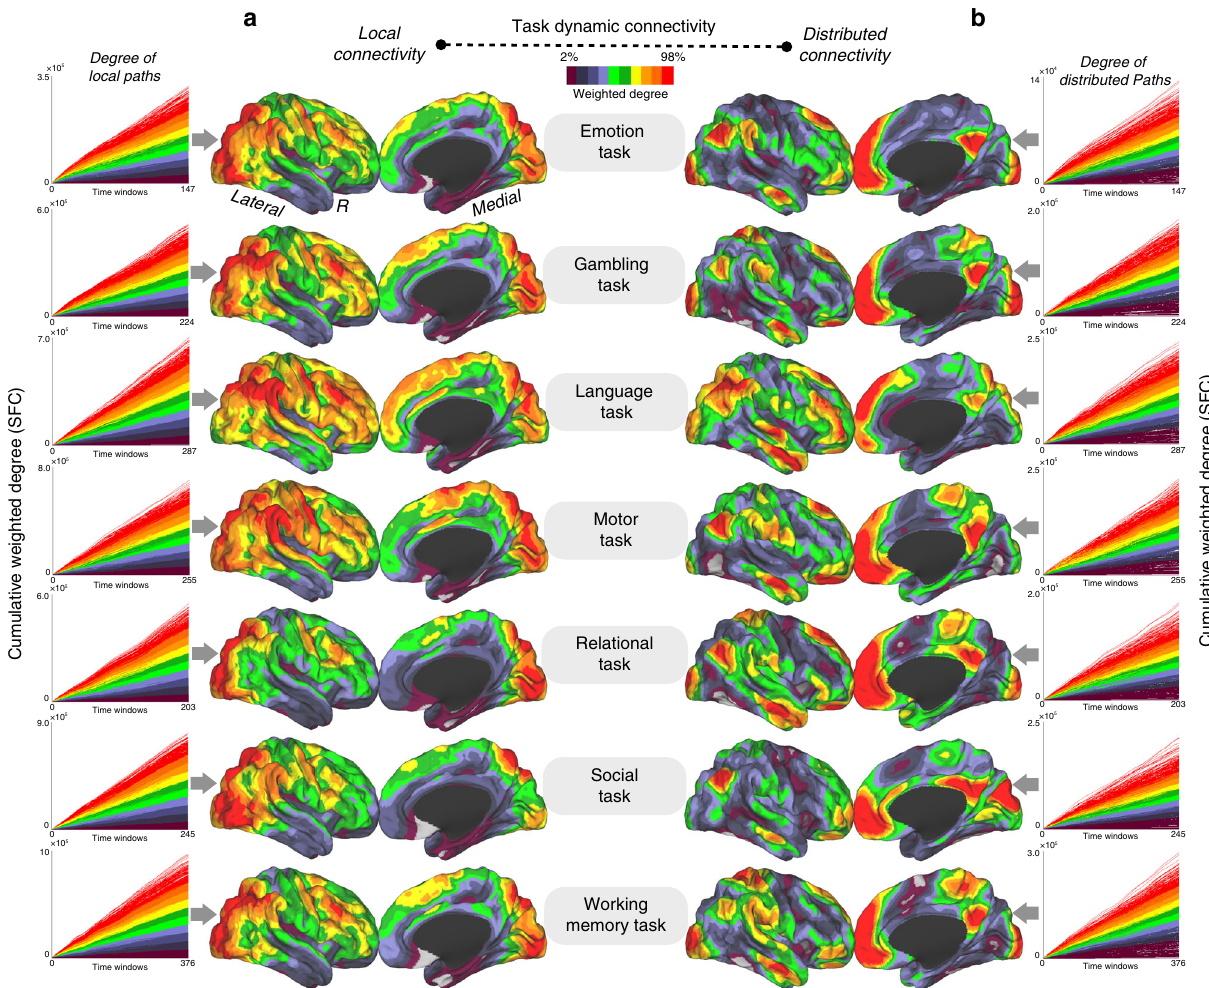
Fig. 2 a , b For each cognitive task, the accumulative SFC score capturing the functional connectivity streams that reach voxels over time is shown, as is the average cortical maps of the dynamic connectivity patterns and in the form of line graphs ( a local dynamic connectivity and b distributed dynamic connectivity). Color scale in line graphs and cortical maps represent 2 – 98% of the normalized weighted degree of